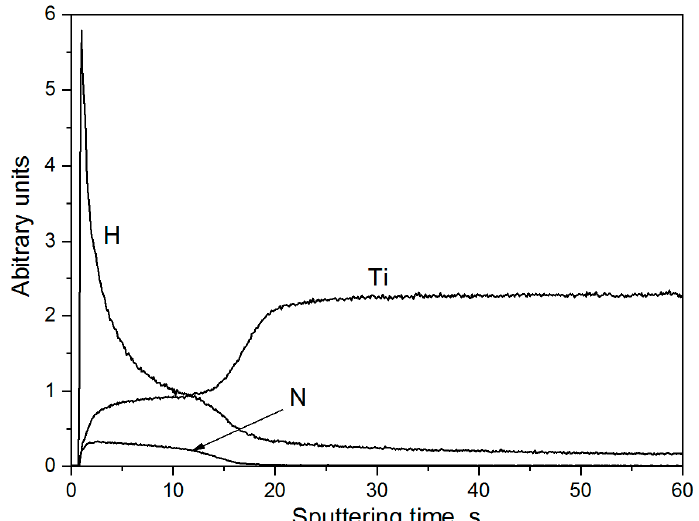
Figure 6. Element distribution profiles in the TNSMC specimens of the Ti0.16Pd with a δ —TiN coating immediately after cathode hydrogenation in a physiological saline solution.